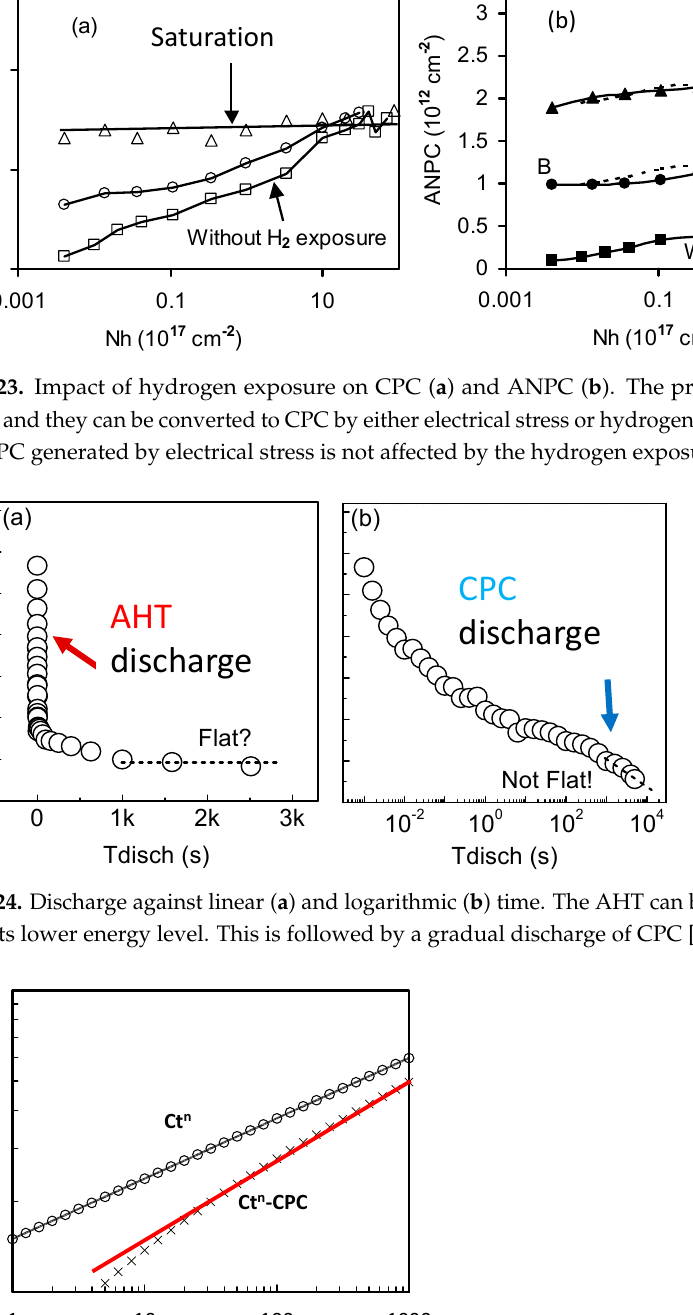
Figure 23. Impact of hydrogen exposure on CPC ( a ) and ANPC ( b ). The precursors for CPC are limited, and they can be converted to CPC by either electrical stress or hydrogen exposure. In contrast, the ANPC generated by electrical stress is not affected by the hydrogen exposure [54].